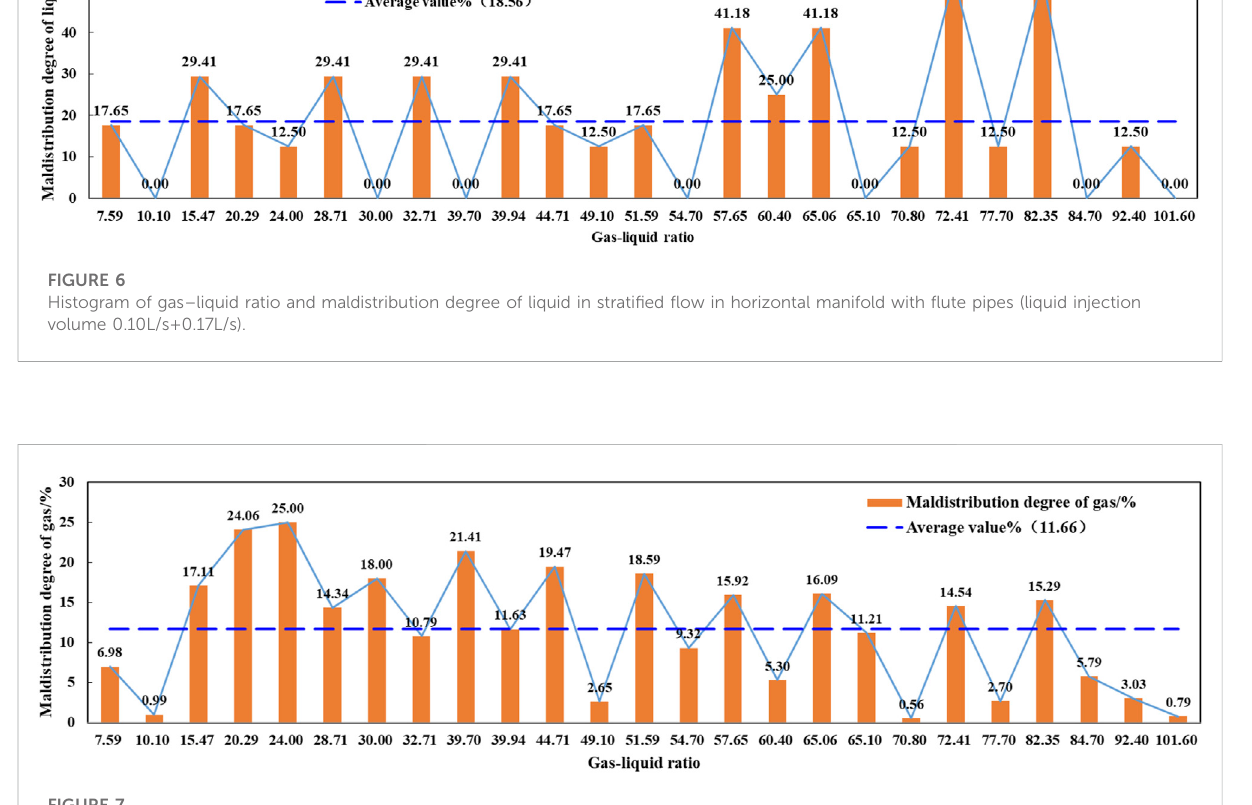
Frontiers in Earth